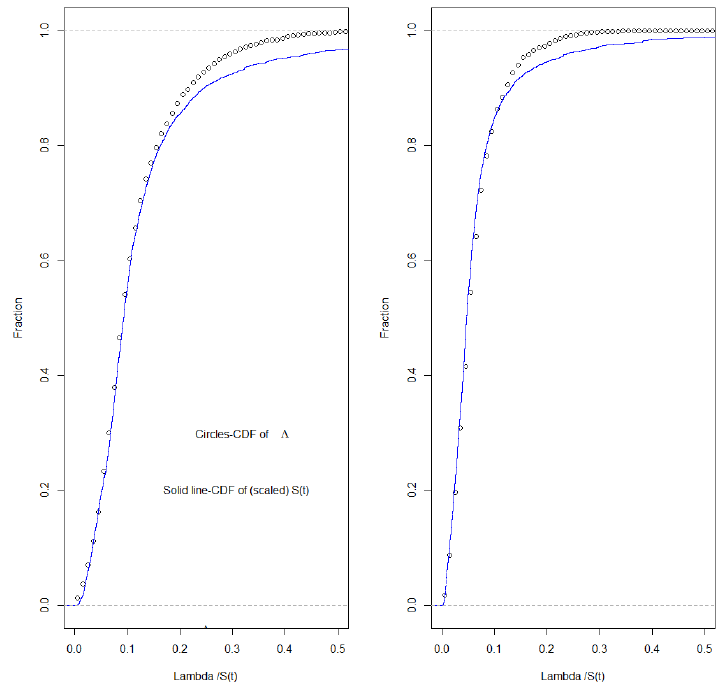
Figure 10. Empirical CDFs of (cid:51) (circles) and scaled S(t) (blue line) for two Norwegian catchments.